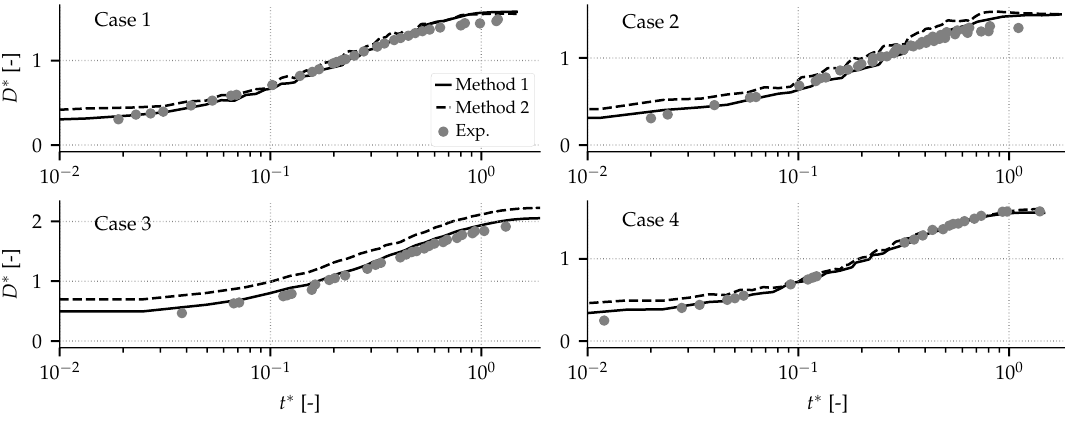
Figure 6. Validation of the numerical model versus cases from [38]. Symbols represent the experiment while the plain and dashed lines represent Method 1 and Method 2,